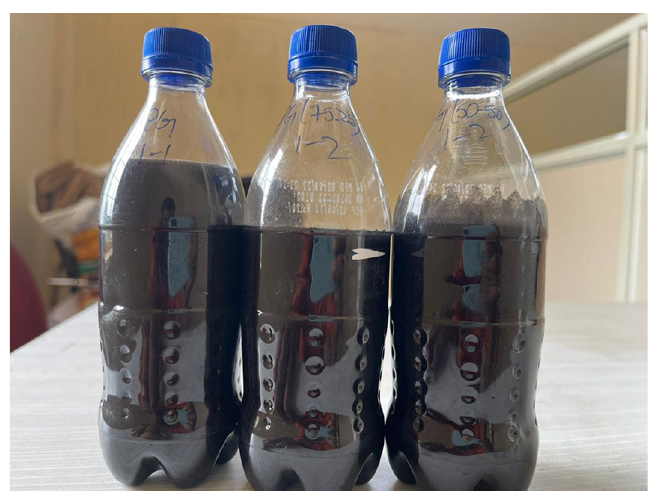
Figure 1. Prepared nanofluid